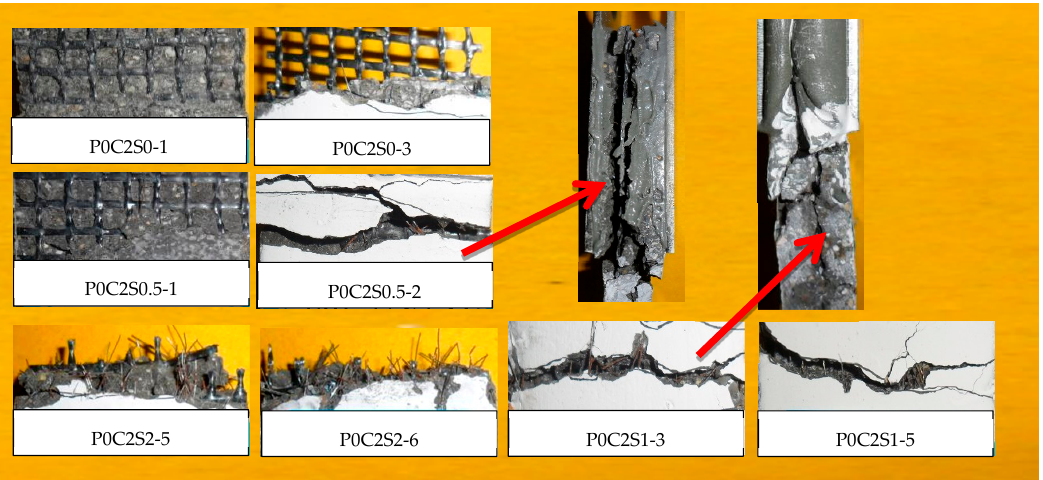
Figure 14. Fracture behavior of plain matrix, matrix reinforced with 1% steel fibers, and TRM (one ‐ layer) specimens with steel fibers.